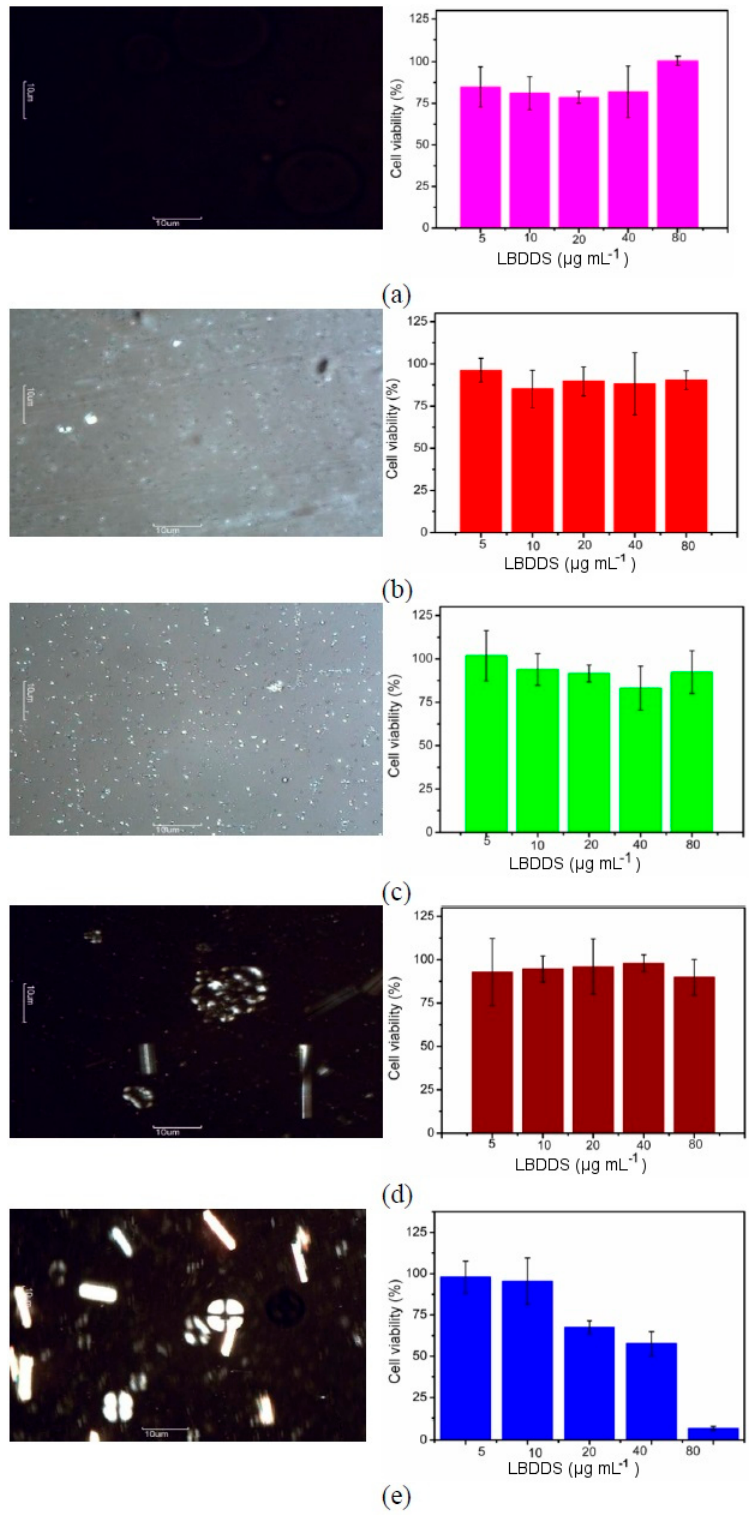
Figure 5. Isotropic/anisotropic behavior assessed by CPLM ( left , magnification 400×) and respective cell viability assays for the different BNZ-loaded LBDDS (SOR of ( a ) 0.5, ( b ) 1.0, ( c ) 1.5, ( d ) 2.0 and ( e ) 2.5) against Vero cells after 12 h at 37 °C ( right ). Note: data of the relative cell viability are expressed as the mean ± SD ( n = 3).